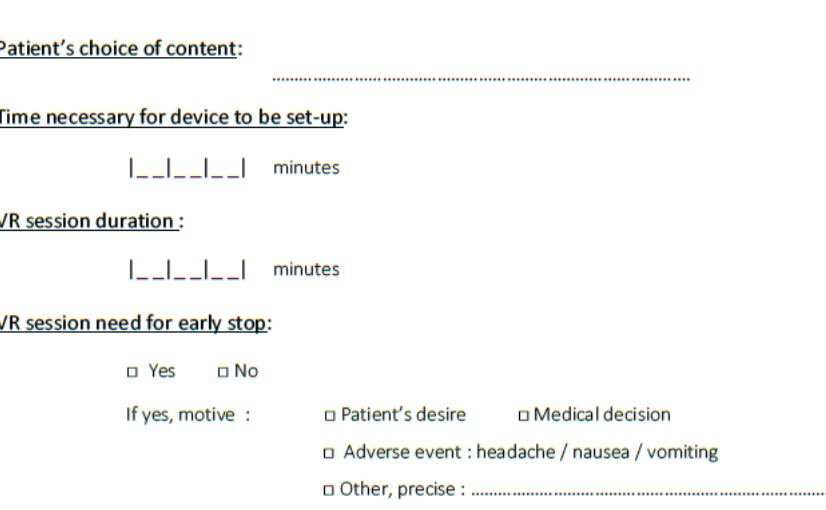
Figure A3. Virtual Reality Headset Tracking Sheet (1 /